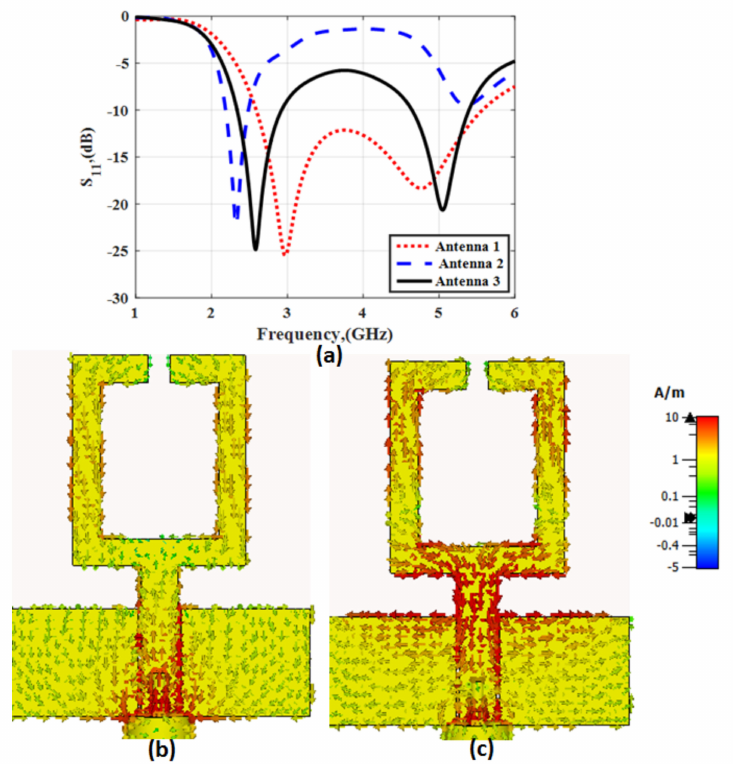
Figure 2. The CPW monopole antennas: ( a ) Simulated S 11 results; ( b ) antenna 3 current distribution at 2.6 GHz; ( c ) antenna 3 current distribution at 5